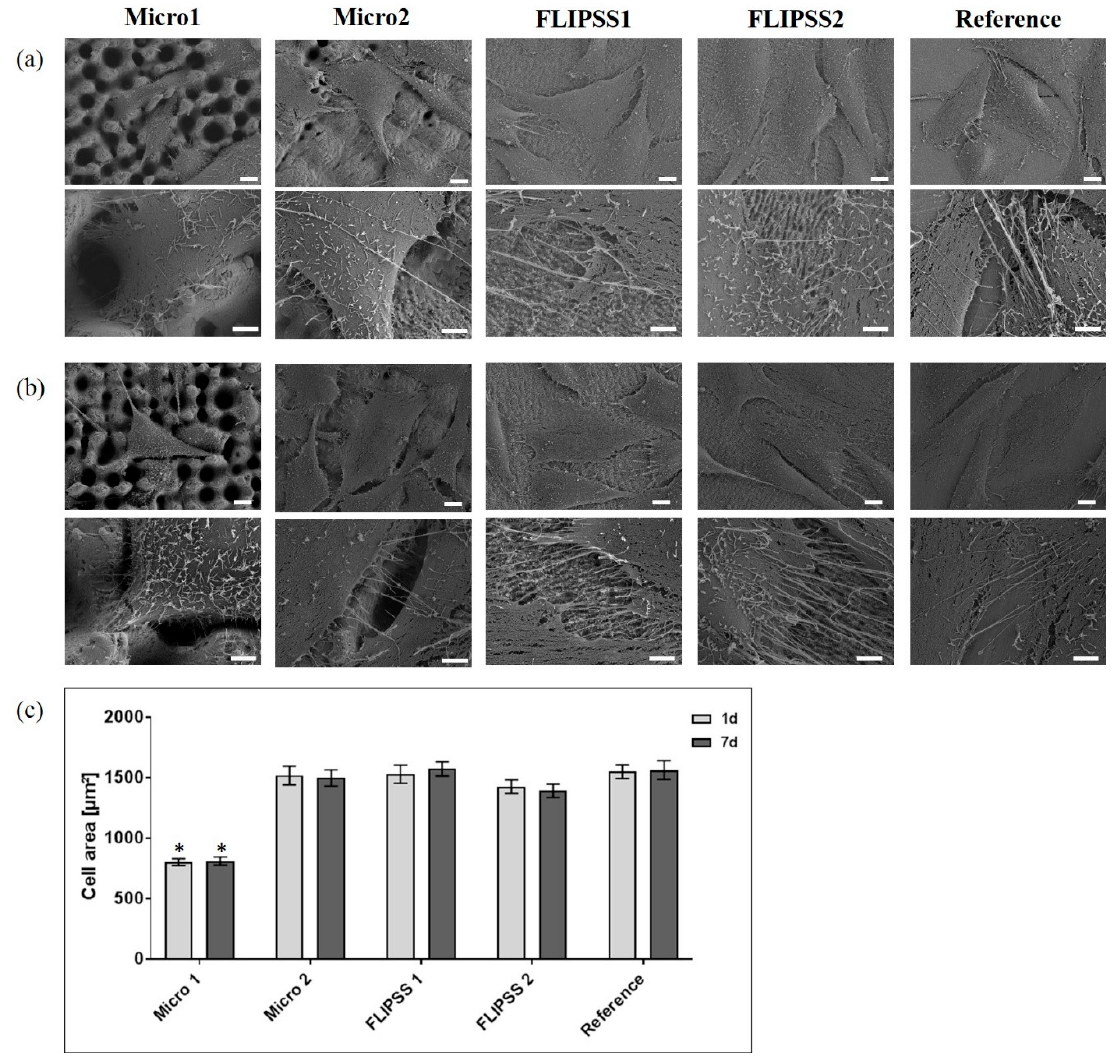
Figure 2. Cell morphology after 24 h on laser-structured samples ( a ) 1 day after laser process, and ( b ) 7 days after laser process (FE-SEM Merlin VP compact, scale bars above: 10 µm, below: 2 µm). ( c ) Cell area of osteoblasts on various nano/micro textured samples compared to planar reference (mean ± s.e.m., Kruskal–Wallis test post hoc uncorrected Dunn´s test, * p < 0.001, n = 40 cells). Note that the cell growth was impaired on Micro1, which is independent of the wettability (see Table